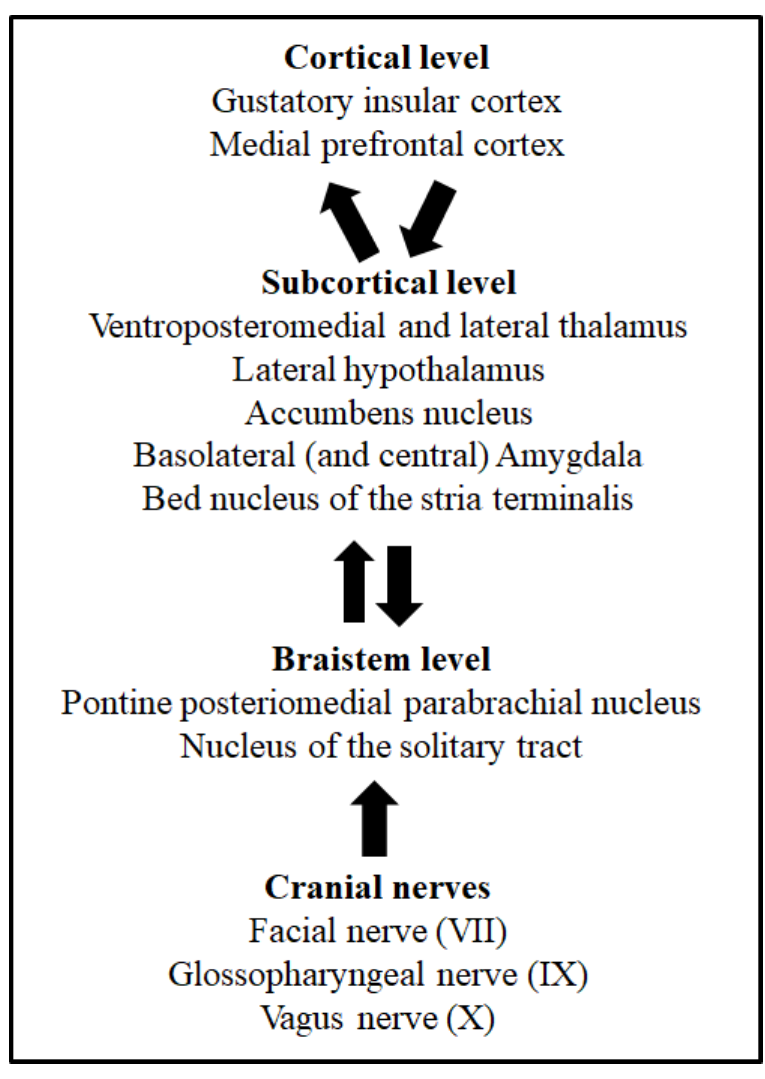
Figure 1. Cortical, subcortical, and brainstem levels of taste processing and taste learning. From bottom to top, arrows indicate the ascending taste pathway from the oral cavity and the afferent and efferent projections associated to taste learning. The cranial nerves involved in taste processing from the oral membranes are also shown.